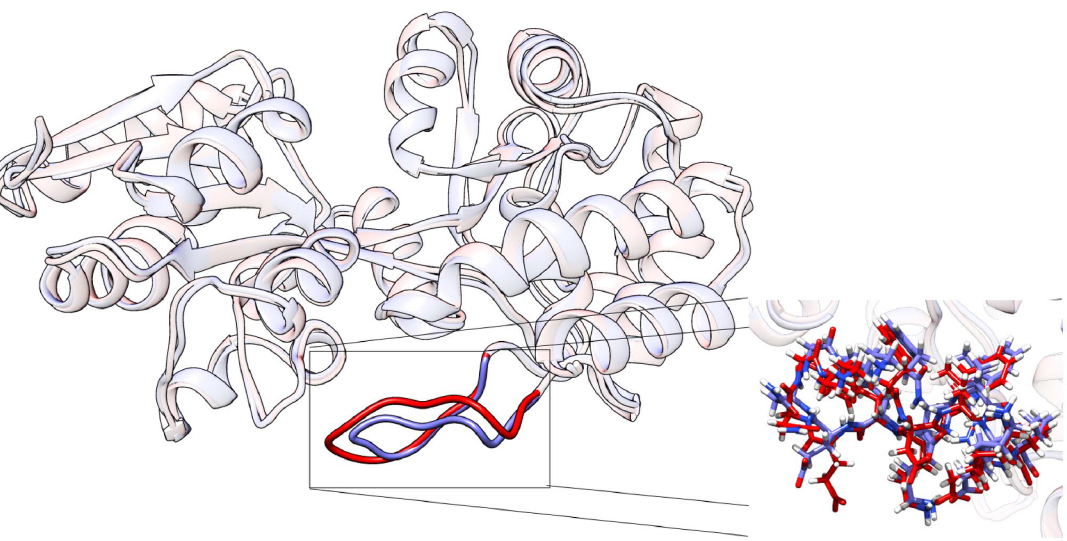
Figure 6. Comparison of the final state of the reverse transition (blue) and the direct transition (red). Structures are nearly identical save for a 10 residue relaxation of a loop region in the balancing interface. Both transitions come to within 1A˚ of their goal.